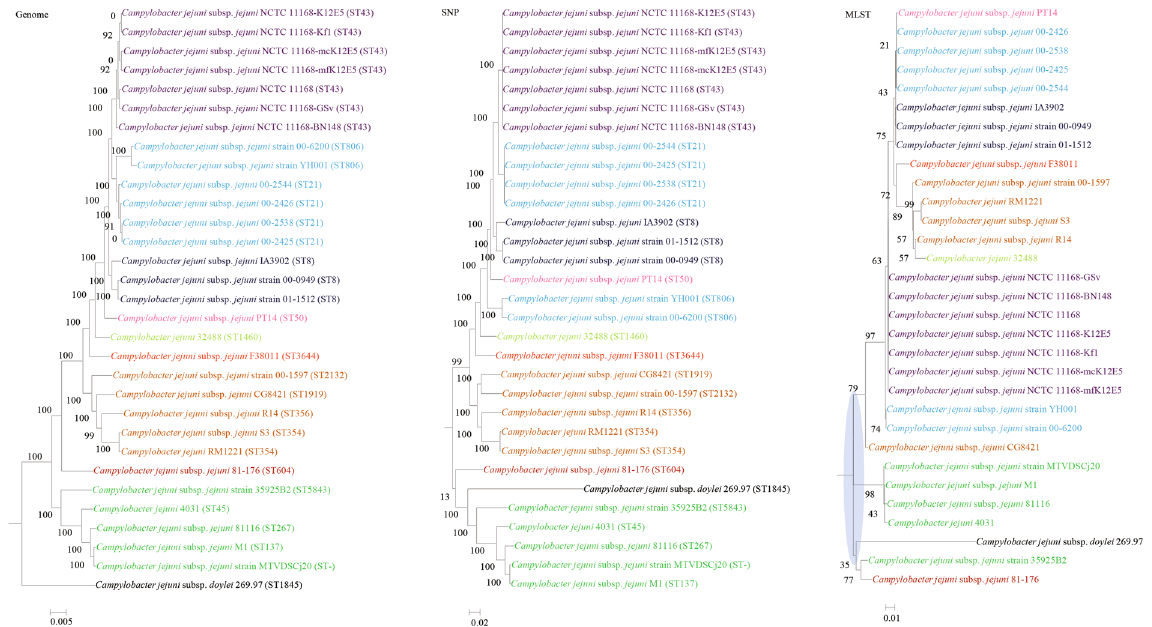
Figure 3. Comparison of phylogenetic trees constructed using genome data (left), SNP data (middle), and MLST data (right) for Campylobacter jejuni . Clusters that were manually selected based on the genome trees are illustrated in different colors. The unresolved polytomies are shaded in blue. A new sequence type is represented by a dash (“ST-”).